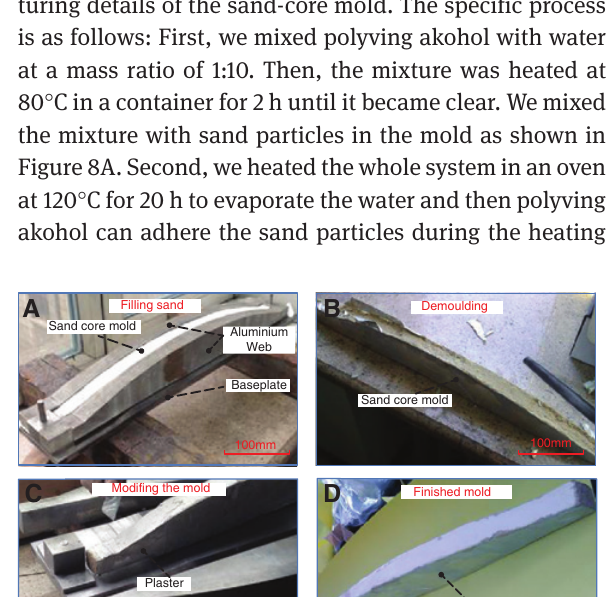
Figure 8: Manufacturing process of sand-particle core mold.